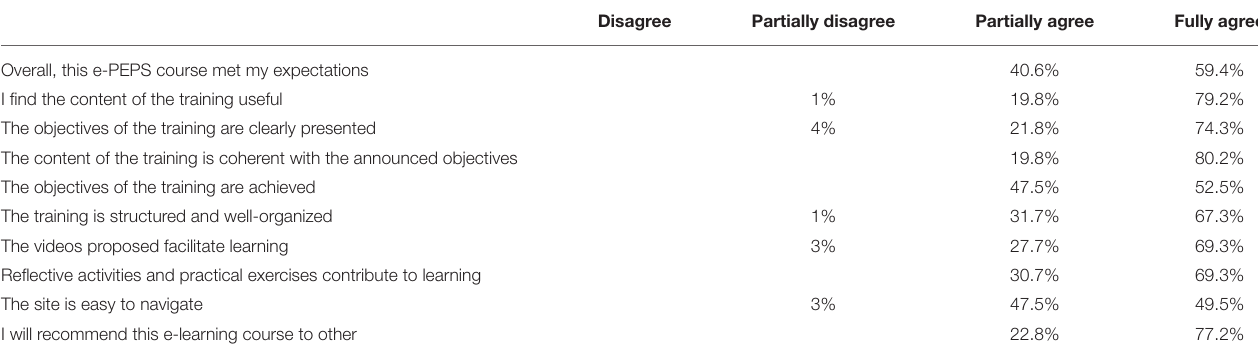
TABLE 2 | Assessment of the satisfaction with the platform e-PEPS ( n =